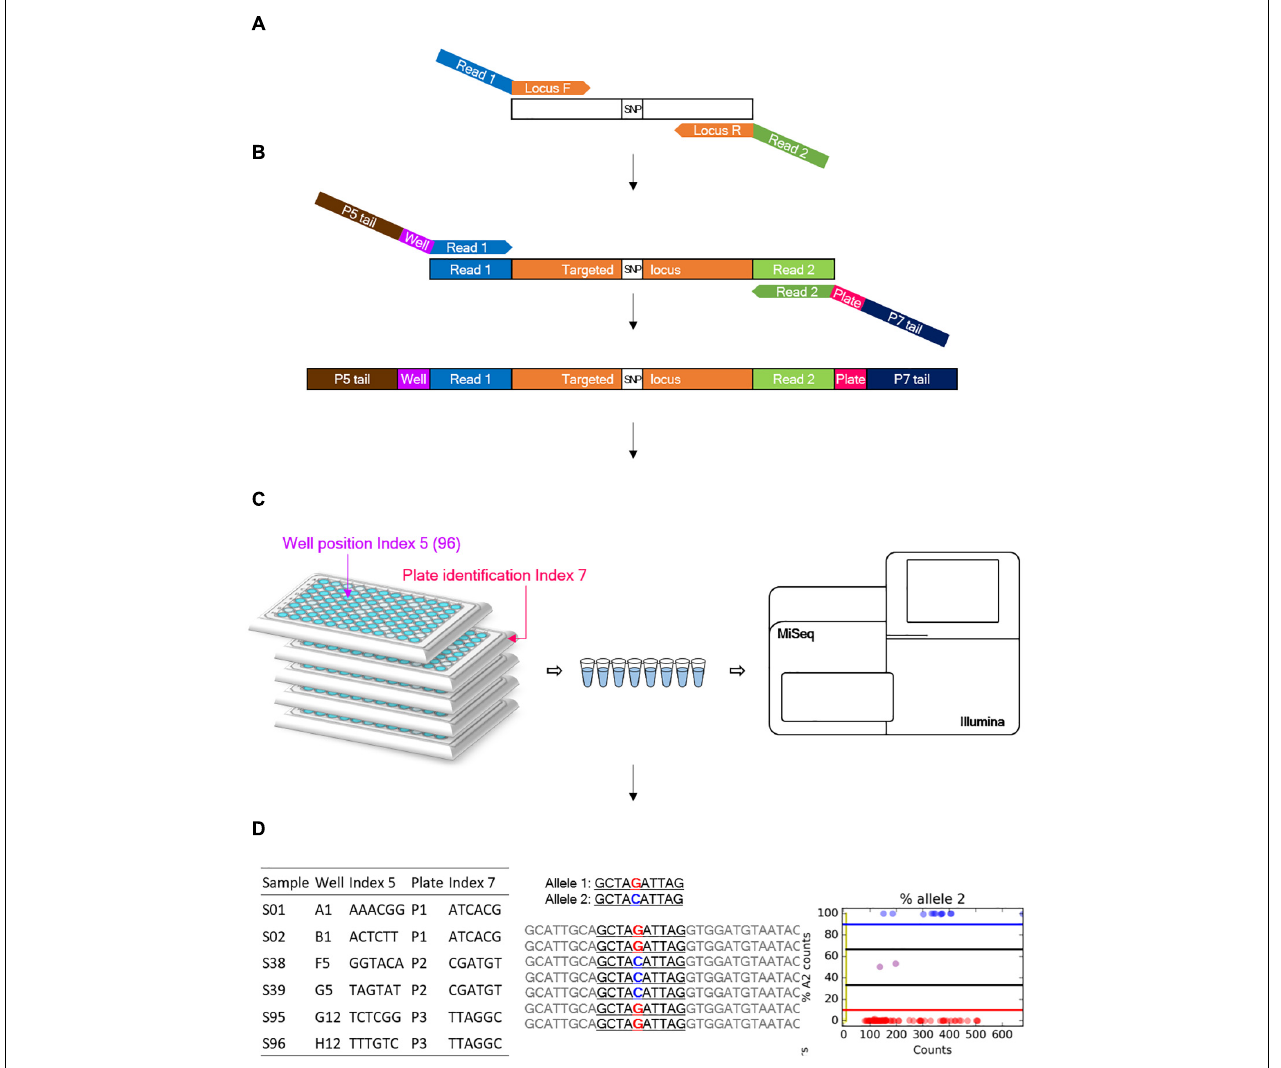
FIGURE 1 | Overview of the genotyping-in-thousands by sequencing (GT-seq) workflow (Campbell et al., 2015). (A) First PCR step: multiple target loci are amplified from a panel of multiplexed primers. (B) Second PCR step: index barcodes are attached. (C) Normalization and sequencing step: all steps are conducted on each plate separately. (D) Each library is then quantified and pooled into a single lane for sequencing on a Miseq or Nextseq